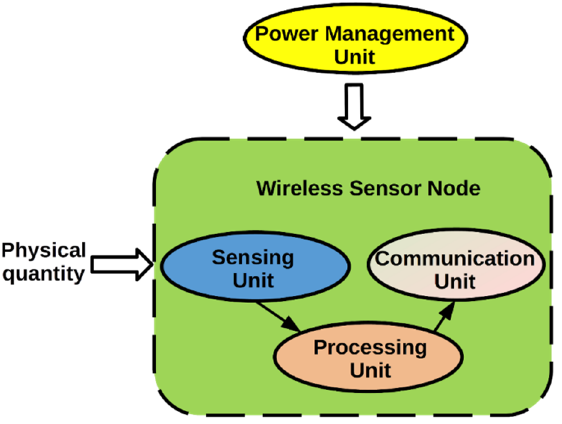
Figure 1. The main elements of the WSN.